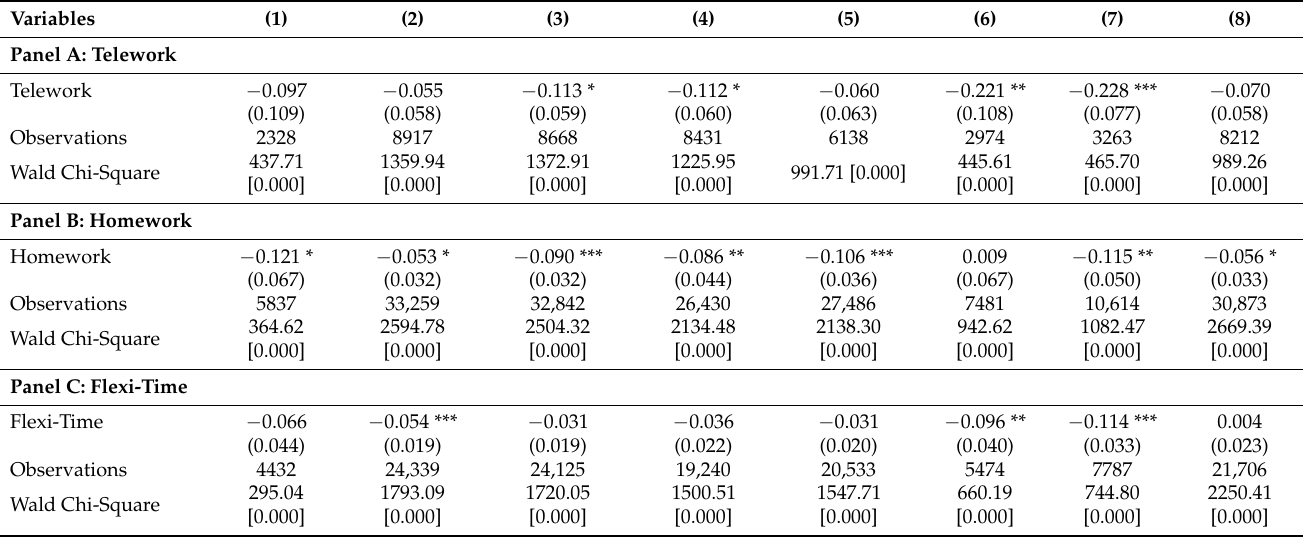
Table 7. Flexible Employment Schemes and Absenteeism for Workers with Disabilities and Health